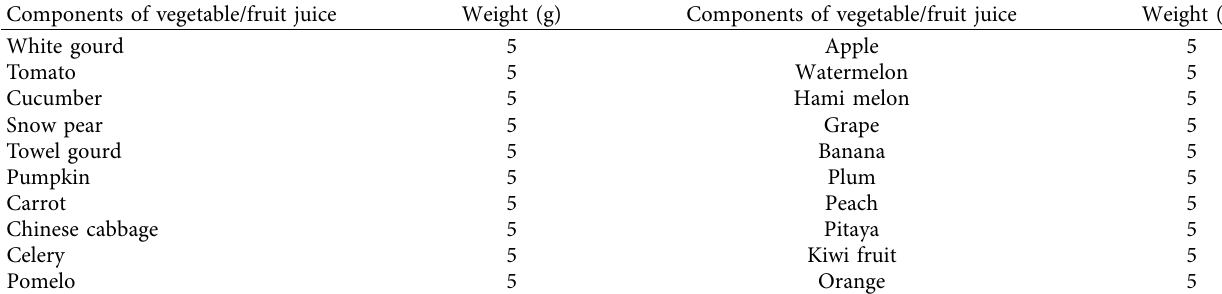
Table 1: Components of vegetable/fruit